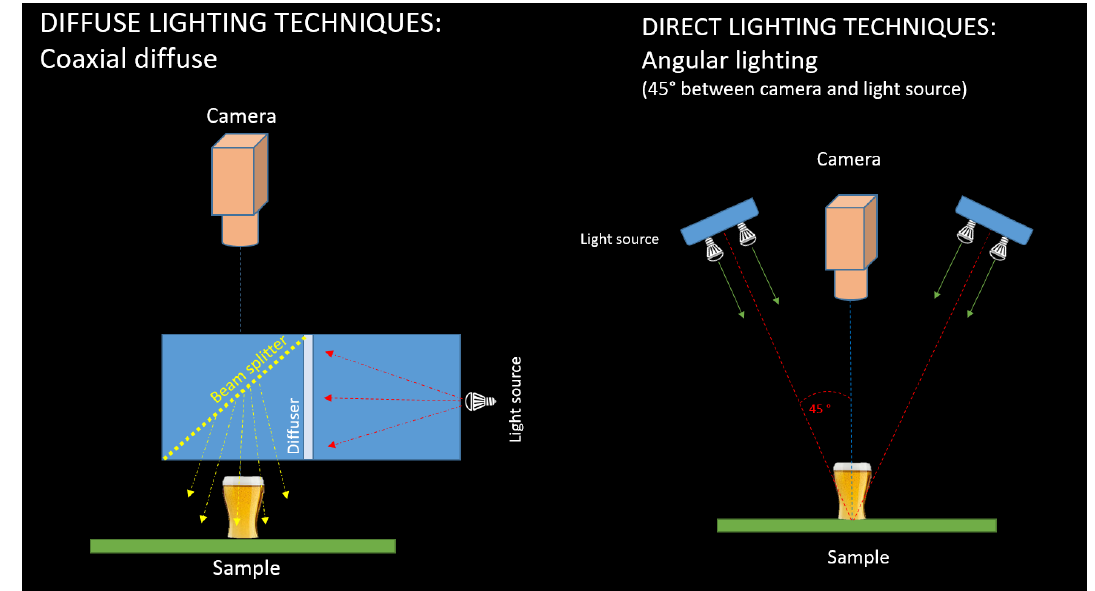
Figure 5. Coaxial lighting techniques with diffuser and angular lighting techniques.